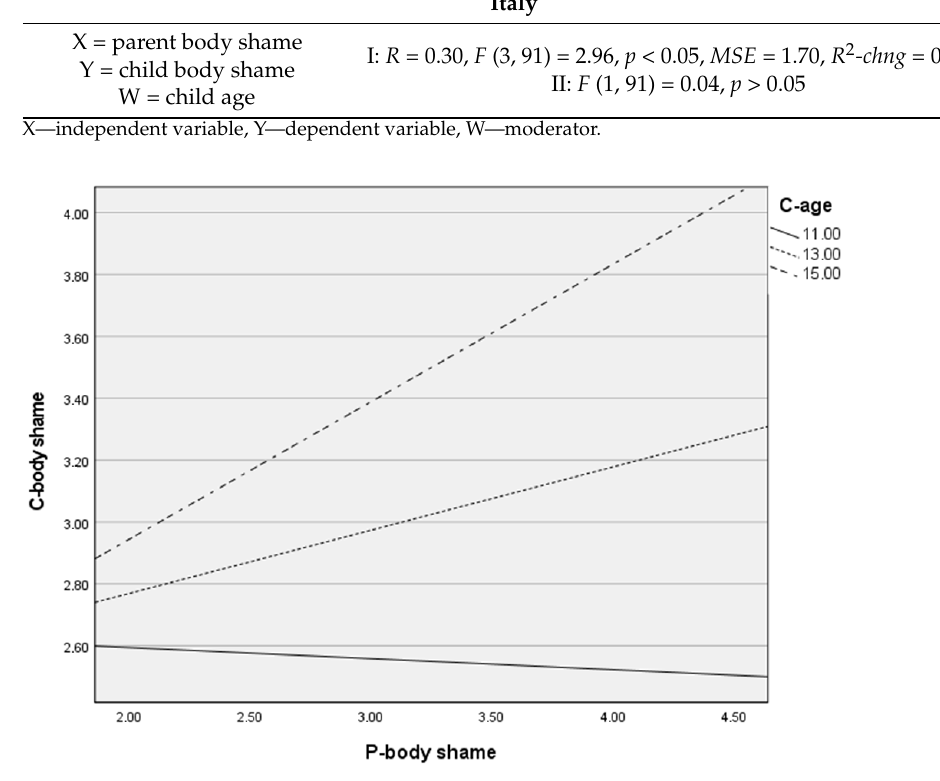
Figure 1. Moderation analysis: the effect of parent body shame (P-body shame) on child body shame (C-body shame) by child age (C-age) among Polish sample.